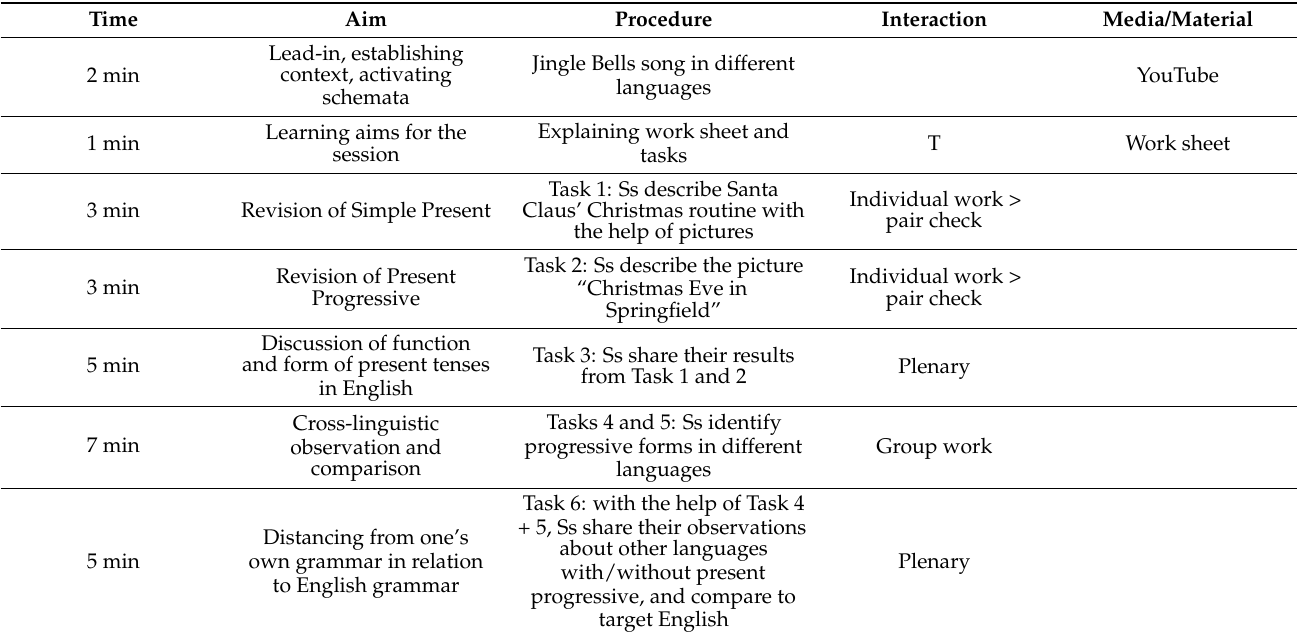
Table 2. Lesson plan for multilingual present